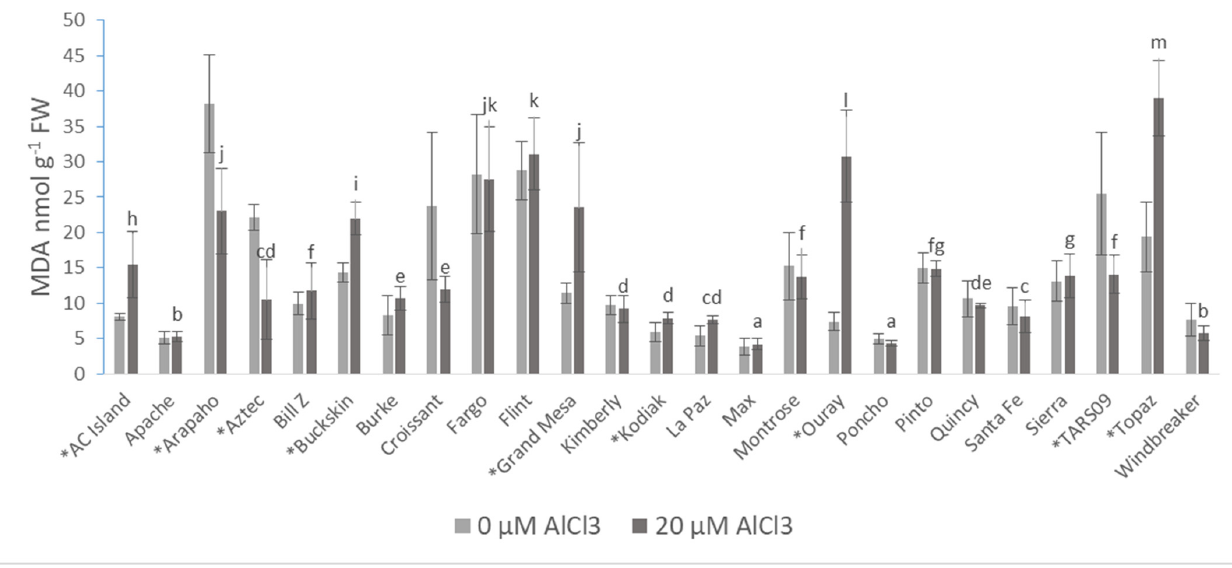
Figure 4. The malondialdehyde (MDA) concentrations of 25 common bean cultivars 72 h after AlCl 3 treatment. Values are the averages of five biological and technical repetitions ± SD. * Significant difference between treatments based on Shapiro–Wilk test ( p ≤ 0.05). Lowercase letters denote a significant difference among the AlCl 3 -treated cultivars. FW: fresh weight. MDA: malondialdehyde.